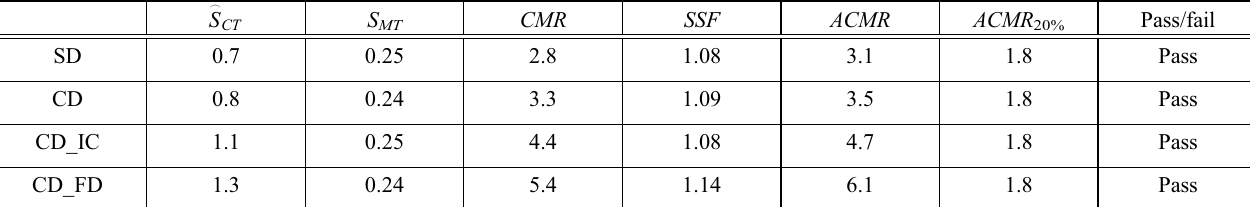
Table 3 Estimation of collapse margin of the model